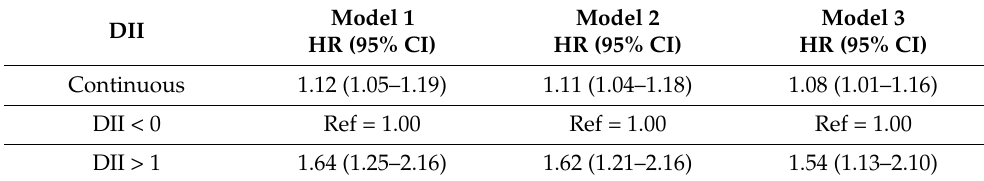
Table 2. Association between DII and all-cause mortality.